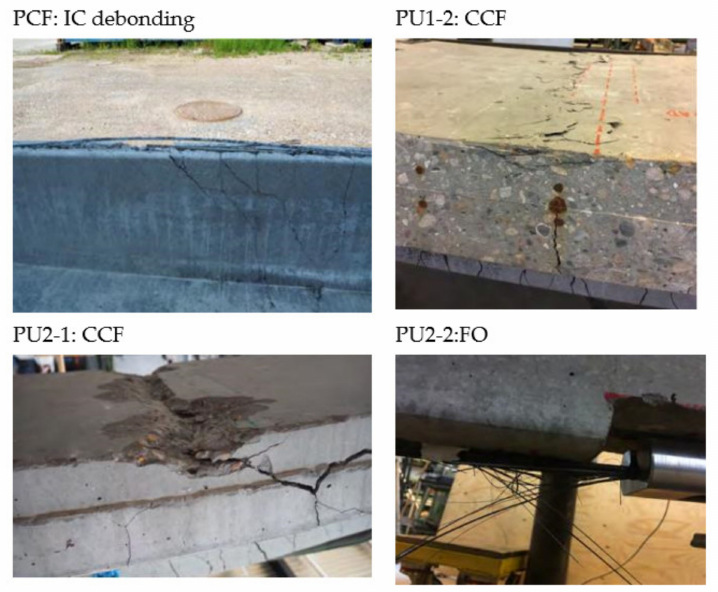
Figure 10. Examples of experienced failure modes.